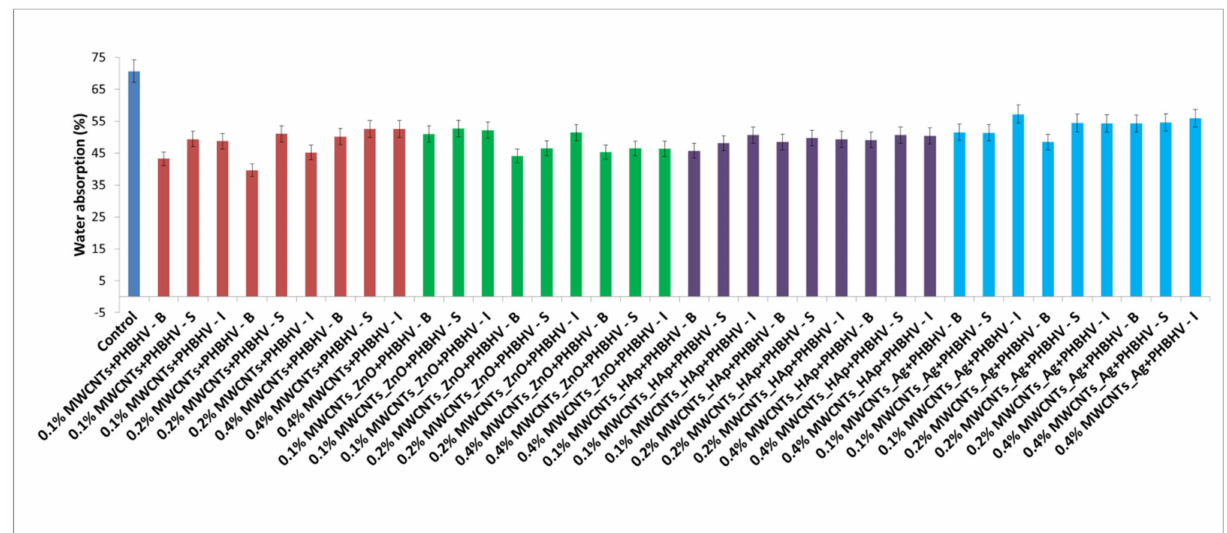
Figure 6. WA for untreated and treated